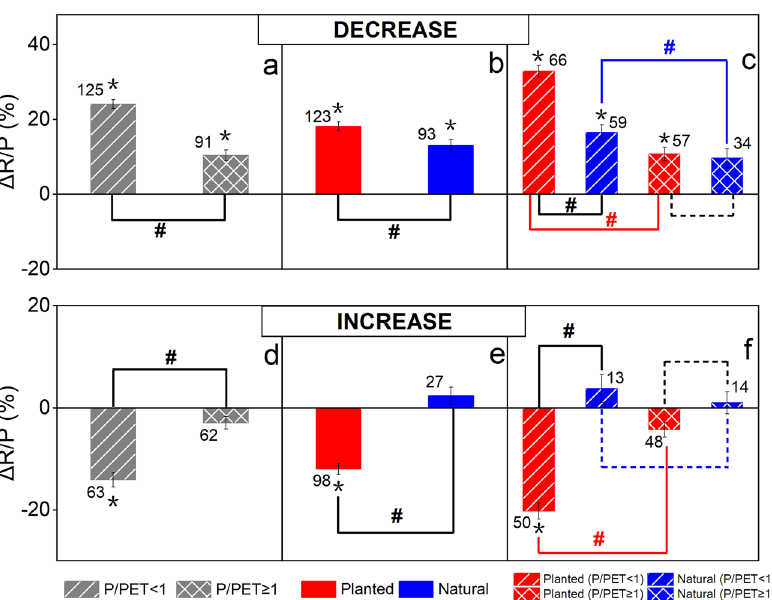
Fig. 1 Differences in the response of runoff coef fi cient change ( Δ R / P ) to treatments (DECREASE and INCREASE) among the eight combinations of forest and climatic region. a – c DECREASE treatment; Panels d – f INCREASE treatment. The number close to each column indicates the sample size (number of watersheds). Error bars indicate the standard error of mean. * indicates signi fi cant difference from zero ( p < 0.05, one-sample t -test, see Supplementary Table 1 for detail). # indicates signi fi cant difference found between two columns connected by solid lines ( p < 0.01, two-sample t -test, see Supplementary Table 2 for detail), while non-signi fi cant comparisons are linked by broken lines. DECREASE: felling or thinning treatment that directly reduce tree numbers; INCREASE: afforestation or reforestation treatment that favors increasing the number of trees.